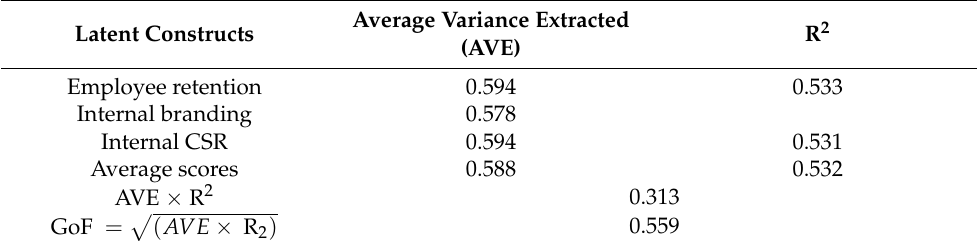
Table 6. Goodness of fit (GoF)